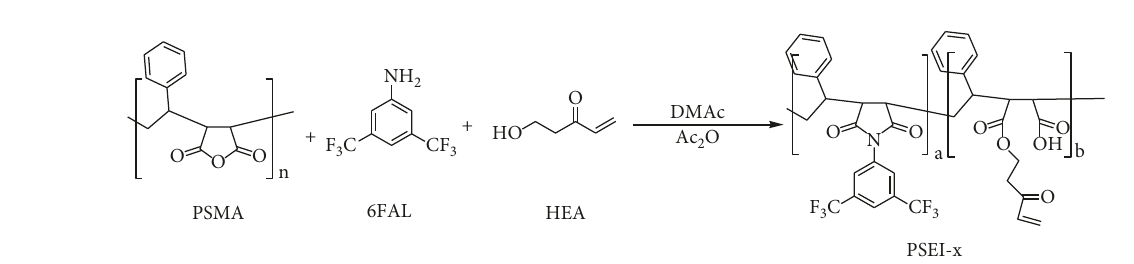
Figure 2: Synthetic scheme of styrene-type side-chain polyimides.